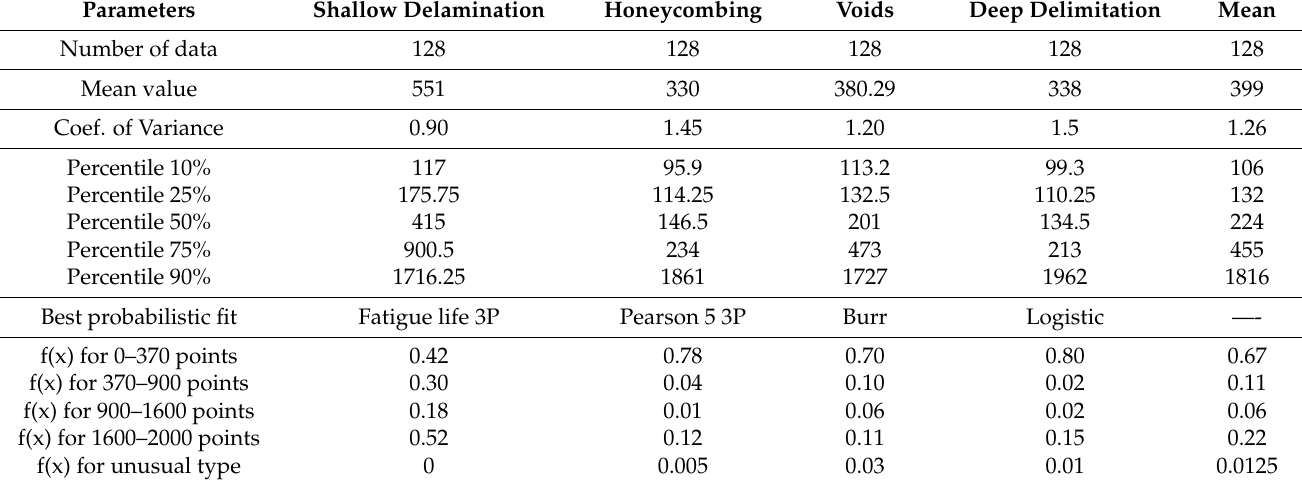
Table 5. Probability result for preprocessed IE signal length based on defect